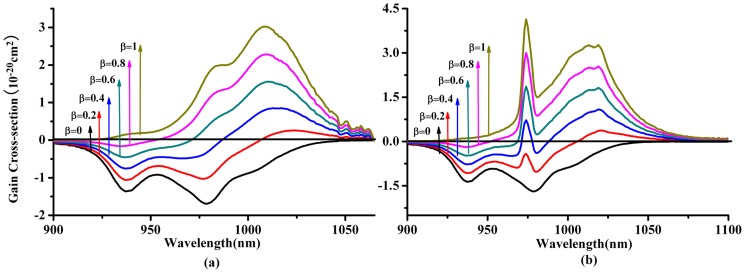
Gain profiles for the Y direction of Yb3+:KBaGd(MoO4)3 crystal obtained by two methods: (a) the RM method and (b) the F-L method.